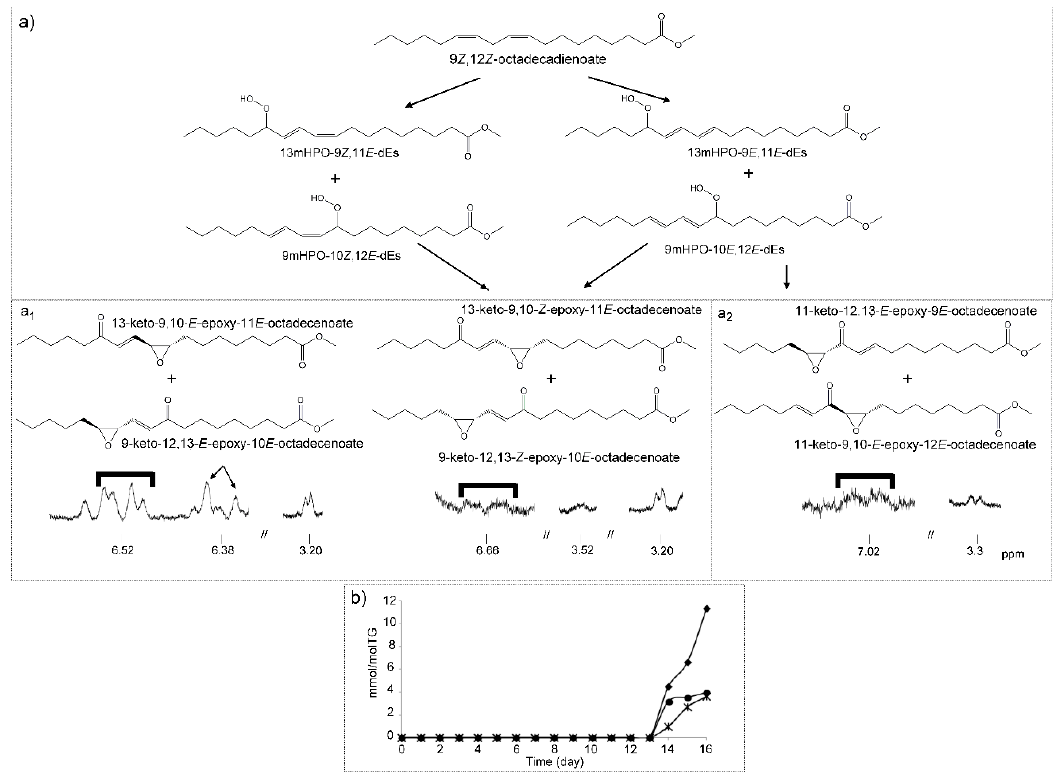
Figure 9. Pathways of formation of keto-epoxy-monoenes (KO-EPO-mEs) proposed by some authors under certain oxidation conditions [25,63,69]. ( a 1 ) KO-EPO-mEs having in their chains keto-double bond-epoxy, together with the enlargement of some regions of the 1 H NMR spectra in which the signals of these compounds appear; ( a 2 ) KO-EPO-mEs having in their chains double bond-keto-epoxy together with the enlargement of some regions of the 1 H NMR spectra in which the signals of these compounds appear. ( b ) Evolution of the concentration, expressed as mmol/mol TG versus time given in days of: 13-keto-9,10 -E- epoxy-11 E -octadecenoate + 9-keto- 12,13 -E -epoxy-10 E -octadecenoate ( ♦ ); 11-keto-12,13- E -epoxy-9 E -octadecenoate + 11-keto- 9,10- E -epoxy-12 E -octadecenoate ( • ); 13-keto-9,10- Z -epoxy-11 E -octadecenoate + 9-keto-12,13- Z -epoxy-10 E -octadecenoate (*).